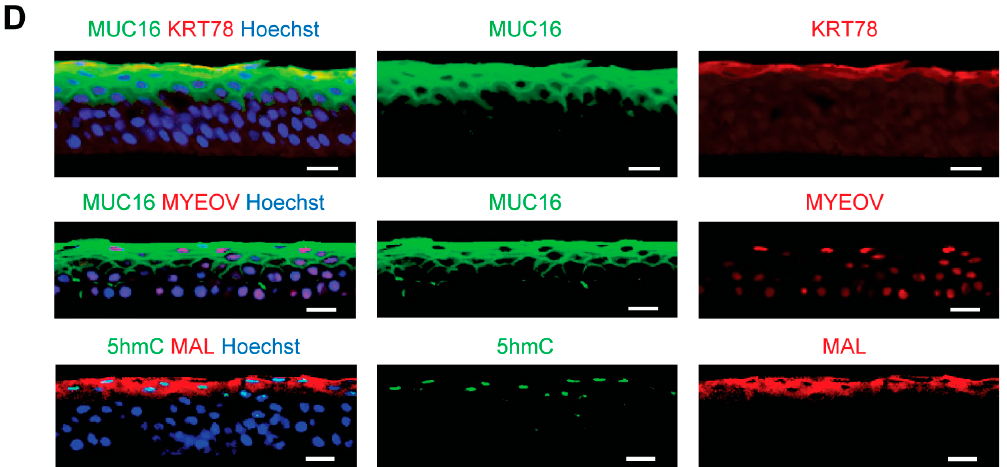
Figure 6. Identification of KRT78, MYEOV, and MAL as epigenetically regulated corneal differen- tiation genes. ( A ) Bar graphs represent relative KRT78 , MYEOV and MAL mRNA expression in TET2 KD cells ( TET2 KD#1: 16.4 ± 18.2%, TET2 ± KD#2: 11.5 ± 15.3% for KRT78 , TET2 KD#1: 59.1 ± 39.5%, TET2 ± KD#2: 51.4 ± 45.9% for MYEOV , TET2 KD#1: 16.2 ± 14.5%, TET2 ± KD#2: 23.7 ± 24.3% for MAL ; n = 8, * p < 0.05 and **** p < 0.0001). Data were analyzed using a Tukey’s multiple comparisons test. ( B ) UCSC genome browser depiction of reduced 5hmC enrichment peaks in the KRT78 , MYEOV and MAL genomic regions of TET2 KD cells. ( C ) Bar graphs represent MUC16 , TET2 , KRT78 , MYEOV , and MAL mRNA expression in sorted MUC16-positive and MUC16- negative cells (relative expression in MUC16-negative cells: 3.9 ± 2.8% for MUC16 , 19.3 ± 19.6% for TET2 , 1.9 ± 4.2% for KRT78 , 5.6 ± 5.5% for MYEOV , 23.0 ± 10.8% for MAL ; n = 5, *** p < 0.001, **** p < 0.0001). Data were analyzed using a paired t -test. ( D ) Representative immunostaining images of MUC16 and KRT78 ( top ), MUC16 and MYEOV ( middle ), and 5hmC and MAL ( bottom ) in the central corneal epithelium. Hoechst 33342 was used for the nuclei staining. n = 3. Scale bar, 20 µ m. The red frames depict the 5hmC peaks reduced in TET2 KD